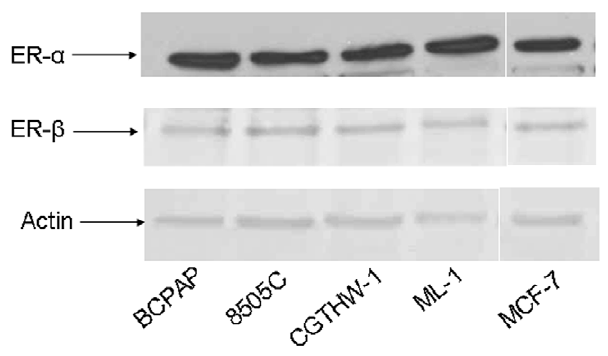
Figure 1. Thyroid cells express estrogen receptor. Whole cell protein (20 m g) was resolved by SDS-PAGE followed by Western blot analysis for ER- a (dilution 1:500), ER- b (dilution 1:1000) and actin (dilution 1:5000). All the cell lines used in this study (BCPAP, 8505C, CGTHW-1 and ML-1) express both ER- a and ER- b at comparable levels.